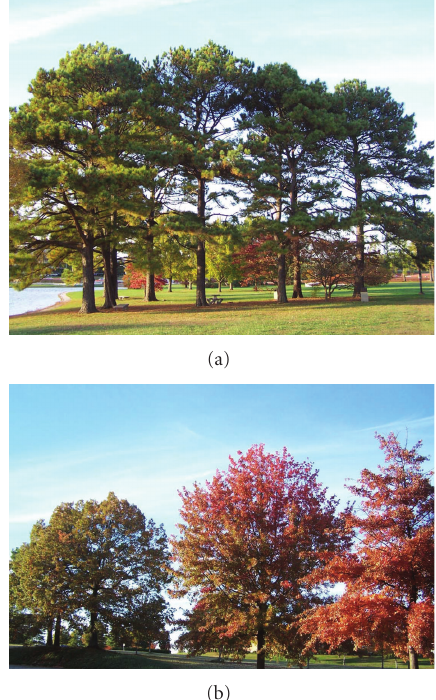
Figure 3: Examples of (a) Softwood trees and (b) Hardwood trees.